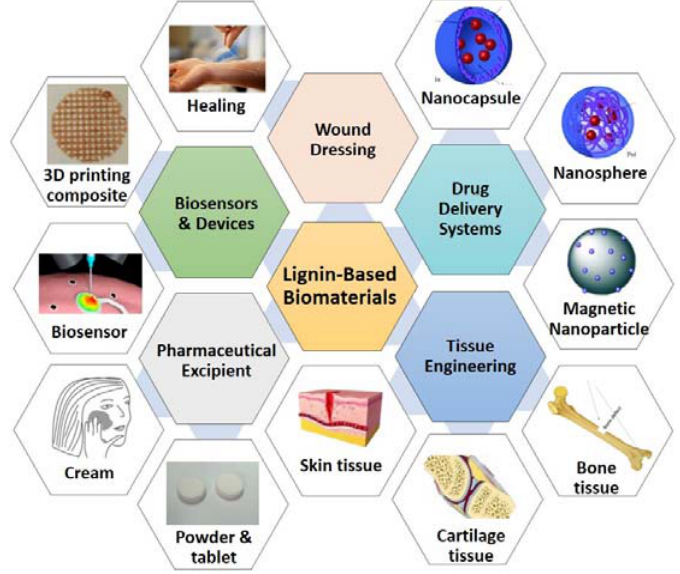
Figure 1. Schematic illustration of the medical applications of lignin-based biomaterials. (Original images’ resources: nanocapsule and nanosphere [11], magnetic nanoparticle [12], skin tissue and cartilage tissue [13], bone tissue [14], wound healing and biosensor [15], 3D printing composite [16], powder and tablet [17], and cream [18]).